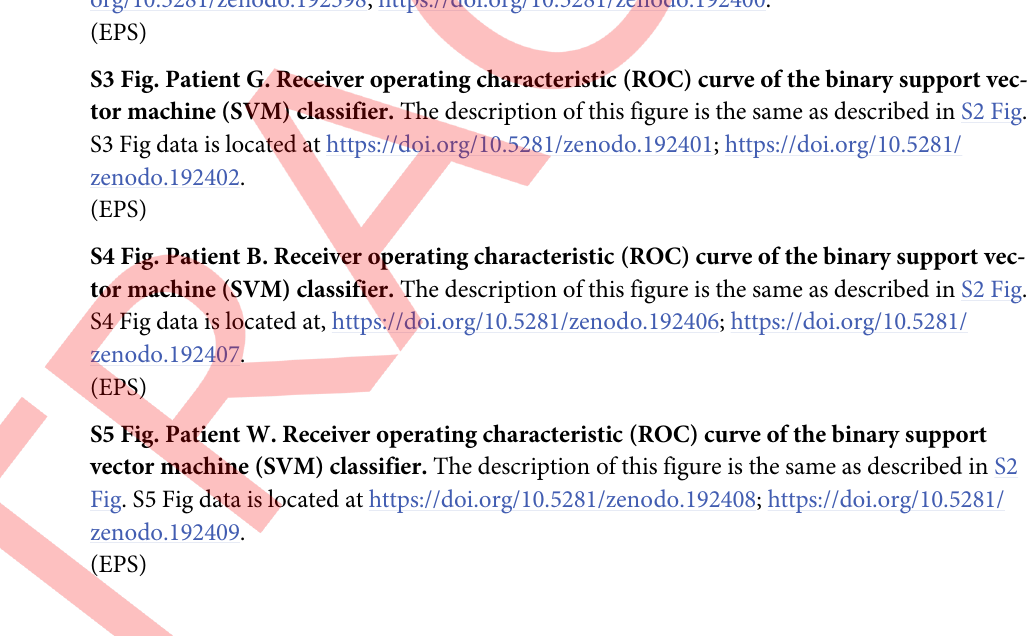
S5 Fig. Patient W. Receiver operating characteristic (ROC) curve of the binary support vector machine (SVM) classifier. The description of this figure is the same as described in S2 Fig. S5 Fig data is located at https://doi.org/10.5281/zenodo.192408;